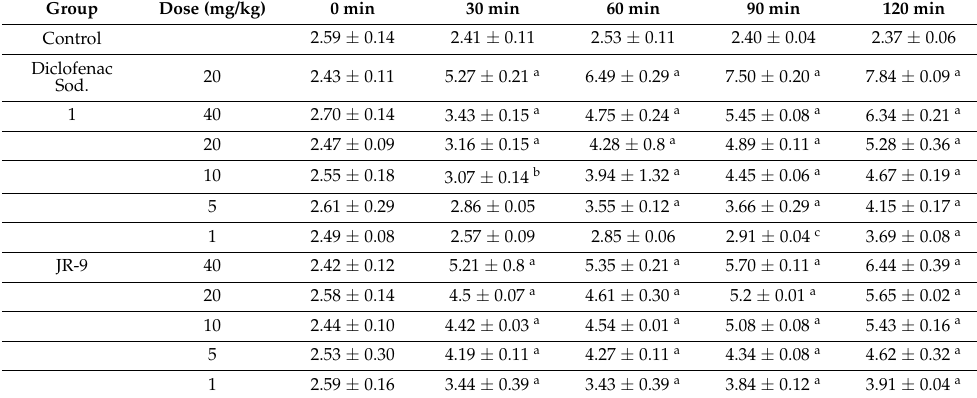
Table 3. The effects of pre-treatment with 1 and JR-9 at intervals of 30 min on tail withdrawal in rats whose tails were dipped in hot water (55.0 ± 0.5 ◦ C). Each value represents mean ± SD, n = 5 ( p < 0.0001 (indicated by a), p < 0.001(indicated by b) and p < 0.05 (indicated by c) indicated significant difference as compared to the control group assessed by two-way ANOVA followed by Tukey test). Group Dose (mg/kg) 0